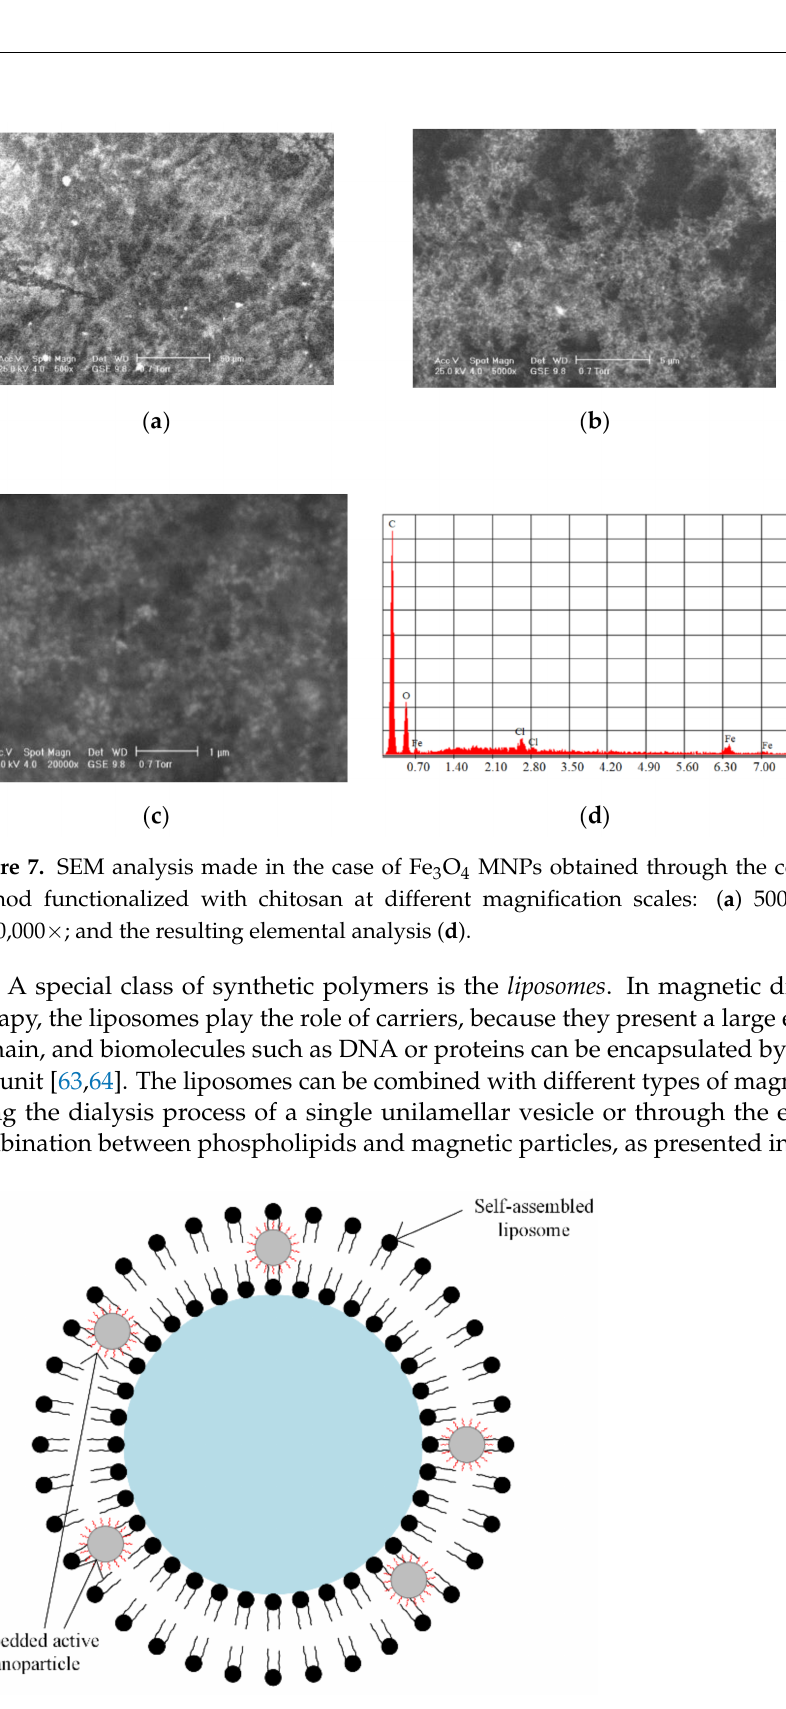
Figure 8. Self-assembled liposome combined with nanoparticles. Solid or water-soluble drugs can be included inside the core region (blue zone) and between interfaces (black spheres); embedded active nanoparticles or oil-soluble drugs in the lipid bilayer can be